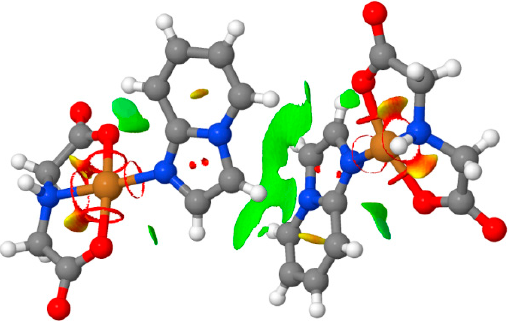
Figure 10. NCI plot of the self ‐ assembled dimer in (1). The NCI plots only show the intermolecular interactions.